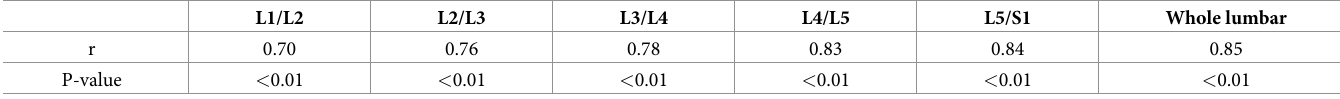
Table 4. Correlation between novel elemental grading system and KL classification for evaluation of radiographic lumbar spondylosis.